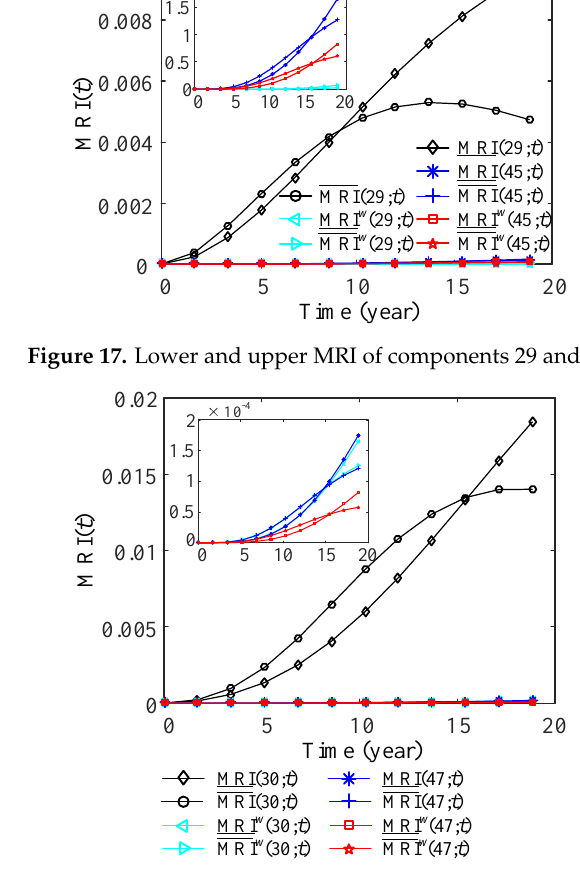
Figure 18. Lower and upper MRI of components 30 and